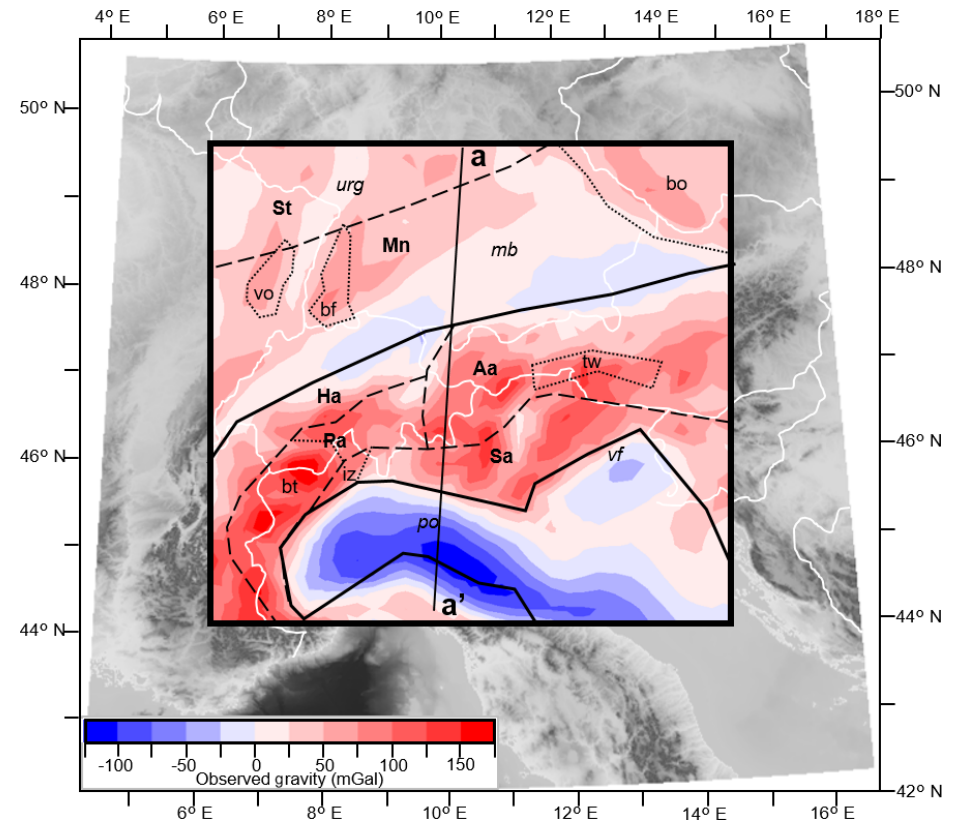
Figure 2. Observed gravity of the region. Values calculated from a spherical approximation at 6km above datum of EIGEN-6C4 global gravity model (Förste et al., 2014) using the ICGEM calculation service (Ince et al., 2019). The line a–a’ represents the cross section in Fig. 3. Locations of key tectonic features are overlaid (definitions shown in Fig. 1a